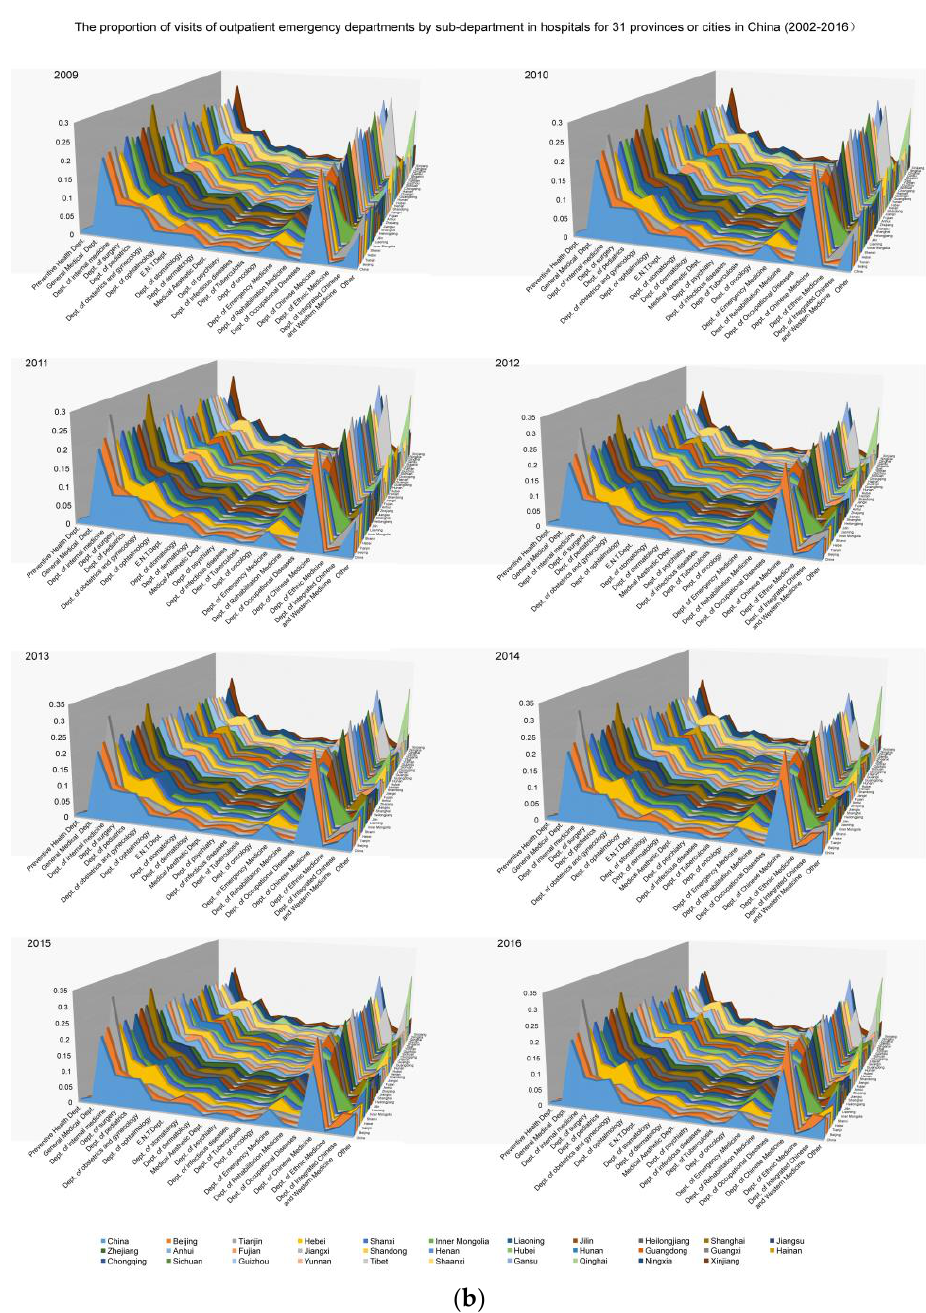
Figure 6. The number of outpatient emergency department visits to different sub-departments in China.